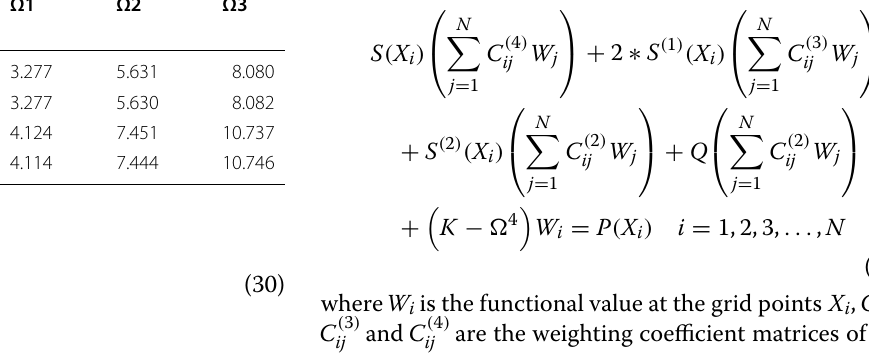
Applying the DQM scheme to the non-dimensional governing Eq. (8) yields: